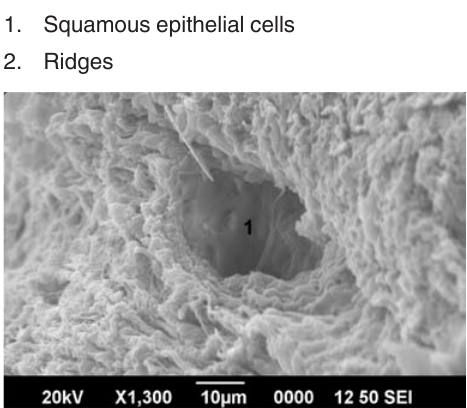
Fig. 2. sEm image of the surface of the ovary. sEm x 1300 1. Epithelial Cleft